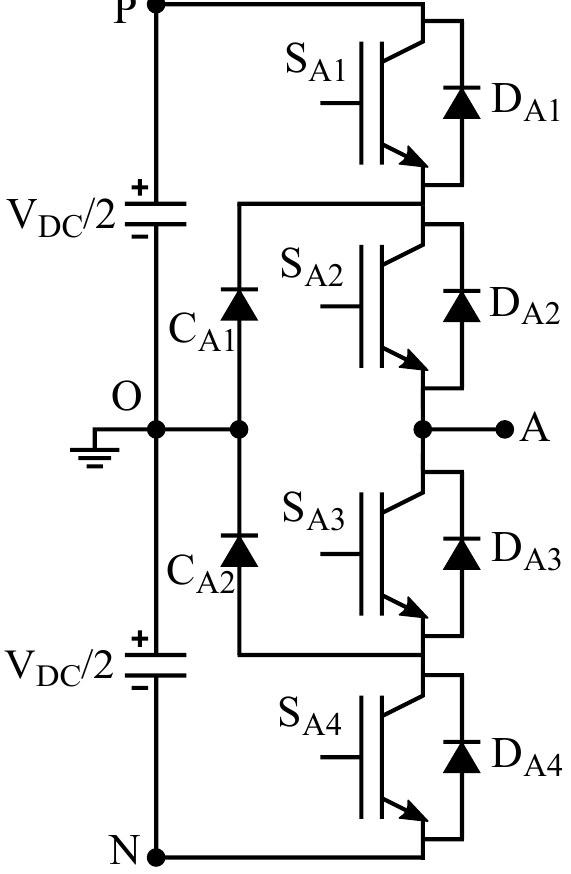
Figure 2. A leg of the NPC